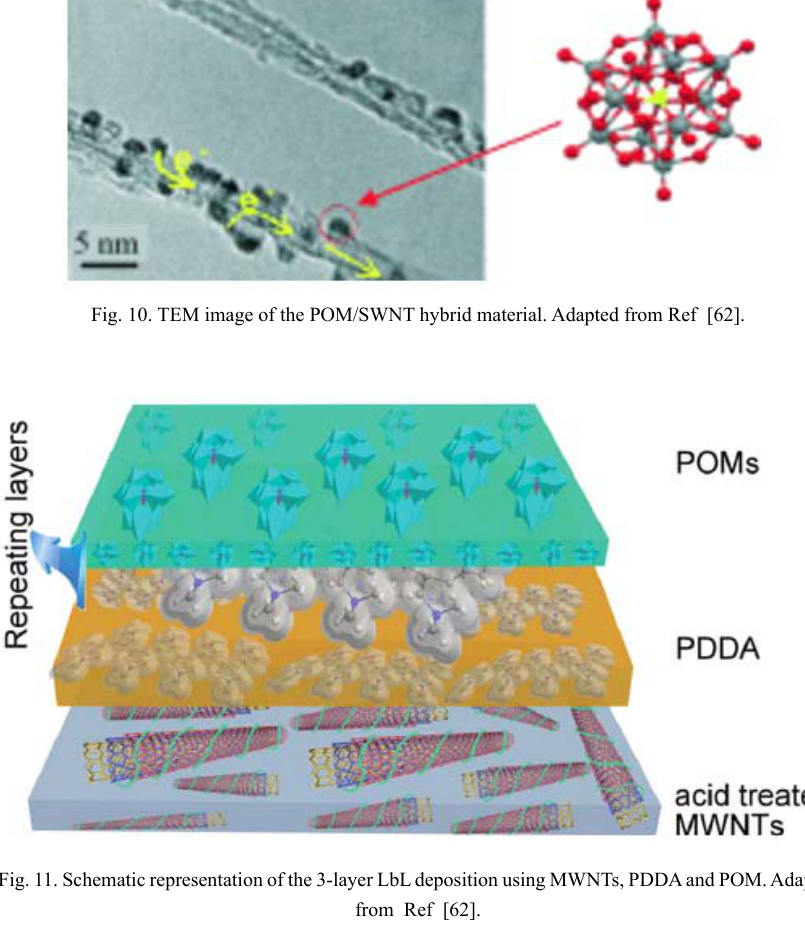
Fig. 11. Schematic representation of the 3-layer LbL deposition using MWNTs, PDDA and POM. Adapted from Ref [61].